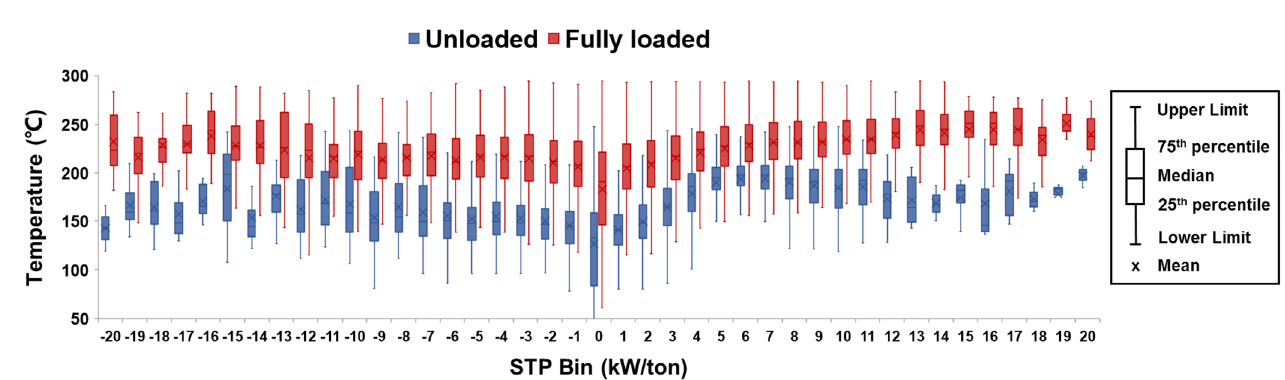
Figure 7. The difference in exhaust temperature between fully loaded and unloaded trucks. (IQR = 75th percentile − 25th percentile, Lower Limit = max (minimum in the sample, 25th percentile − 1.5IQR), Upper Limit = min (maximum in the sample, 75th percentile +